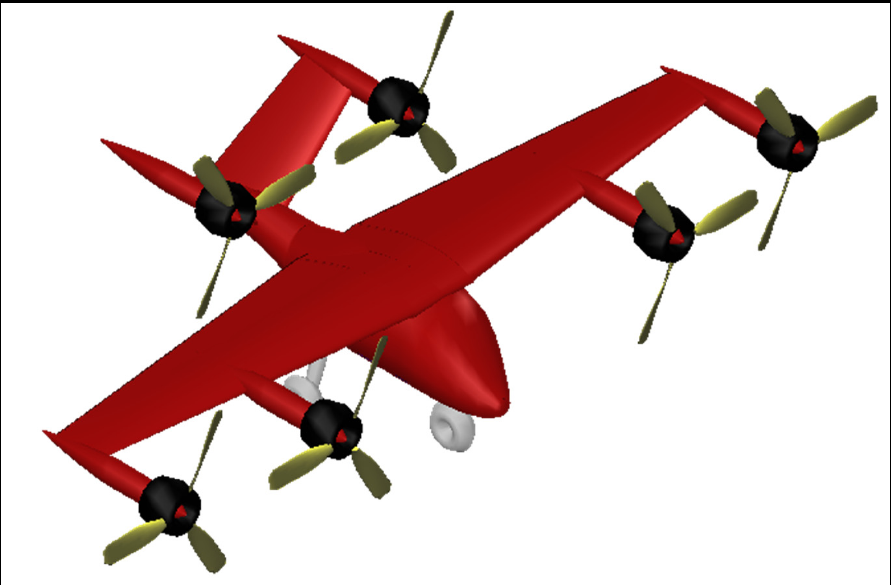
Figure 3. Isometric view of present eVTOL aircraft.